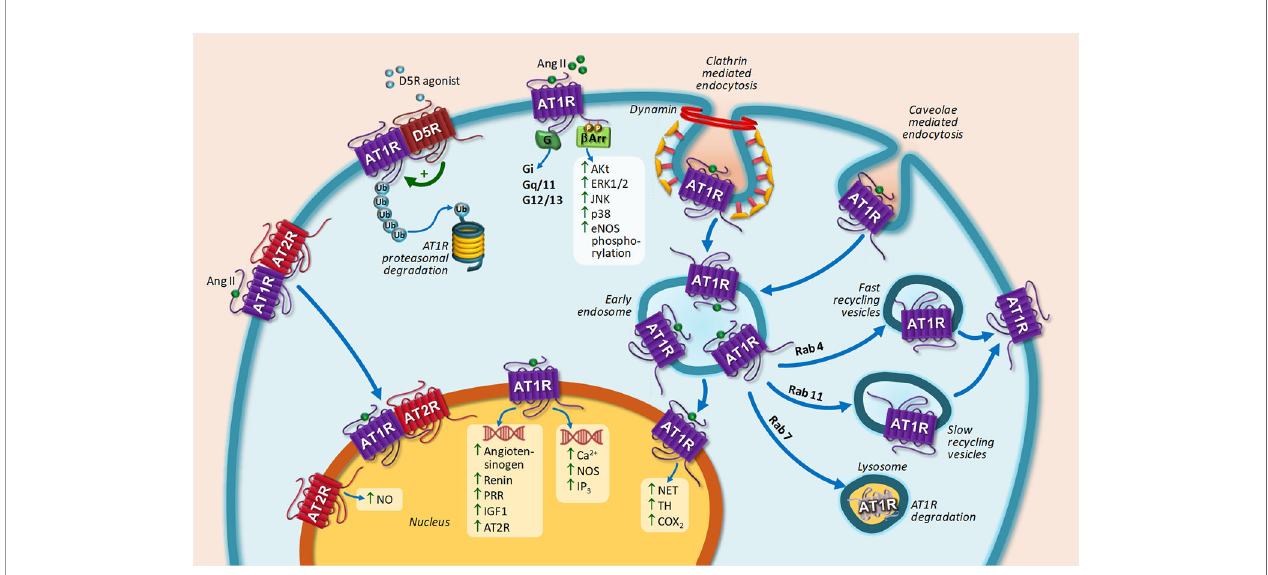
FIGURE 2 | Intracellular traf fi cking of AT1R and main biological responses coupled to nuclear AT1R or AT2R stimulation. AT1R stimulation by Ang II induces G- protein activation, including Gi, Gq/11, and G12/13 (canonical signaling pathway) and G-protein-independent signal transduction (non-canonical pathway) leading to ERK 1/2, JNK, Akt, p38 mitogen-activated protein kinases activation, and eNOS phosphorylation through b -arrestin. Upon agonist stimulation, AT1R is internalized through CCPs and caveolae dependent pathways and then recycled back to the cell surface or targeted lysosome. AT1R-D5R heteromerization induced AT1R proteasomal degradation after D5R stimulation. AT1R translocation to the nucleus induces biological responses depicted in the scheme. AT2R translocation to the nucleus occurs by heteromerization with AT1R. Nuclear AT2R stimulation induced NO generation. Abbreviations: Ang II, Angiotensin II; AT1R, Ang II receptor type 1; AT2R, Ang II receptor type 2; D5R, dopamine receptor type 5; eNOS, endothelial nitric oxide synthase; ERK1/2, Extracellular signal-regulated kinase 1/2; IGF-1, insulin-like growth factor 1; IP3, Inositol triphosphate; JNK, Jun N-terminal kinase; NET, norepinephrine transporter; NO, nitric oxide; PRR, pro-renin receptor; TH, tyrosine hydroxylase; b -arr, b